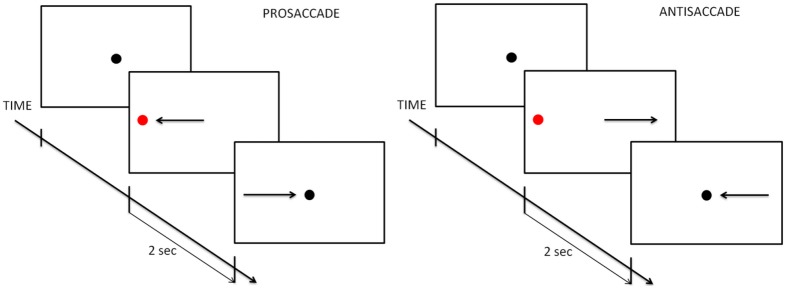
Eye movement tasks.